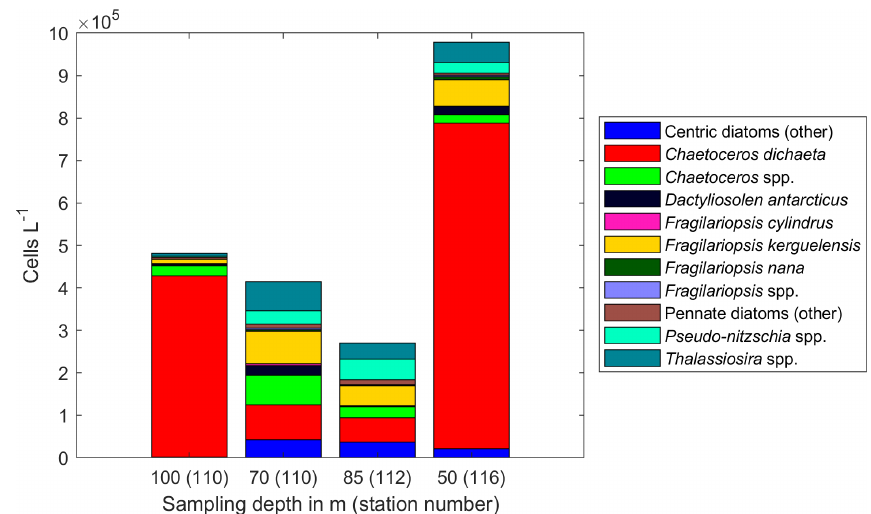
Figure A8. Diatom abundance in available deep samples at Maud Rise. Bars are marked with the sampling depth in meters and the station number in brackets.